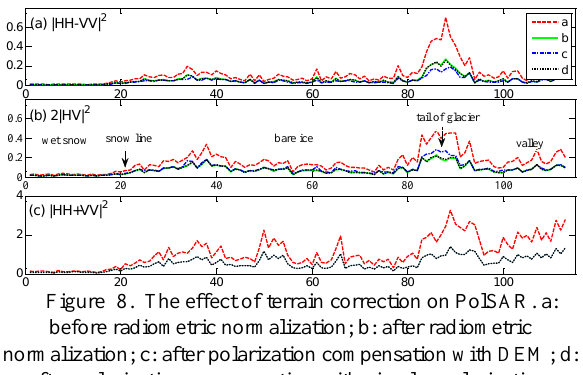
Figure 8. The effect of terrain correction on PolSAR. a: before radiometric normalization; b: after radiometric normalization; c: after polarization compensation with DEM; d: after polarization compensation with circular polarization.